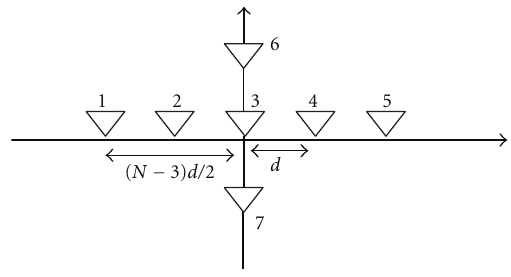
Figure 15: Symmetric PA1 with 7 elements.